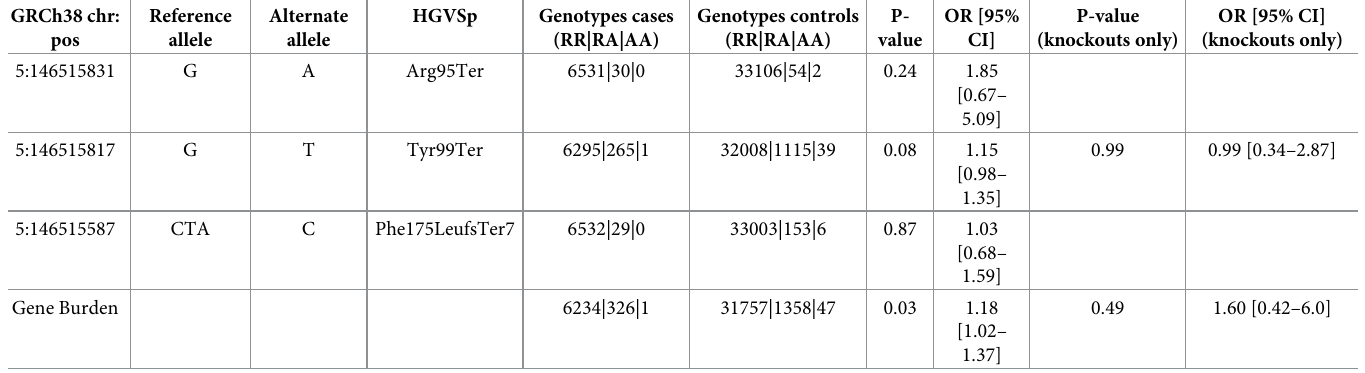
Table 2. GPR151 association with